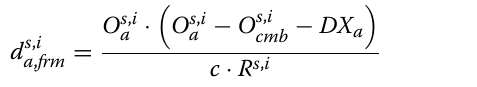
GRECJ Common clock for GPS and Galileo since mid-2018, code clock for the rest (Schaer et